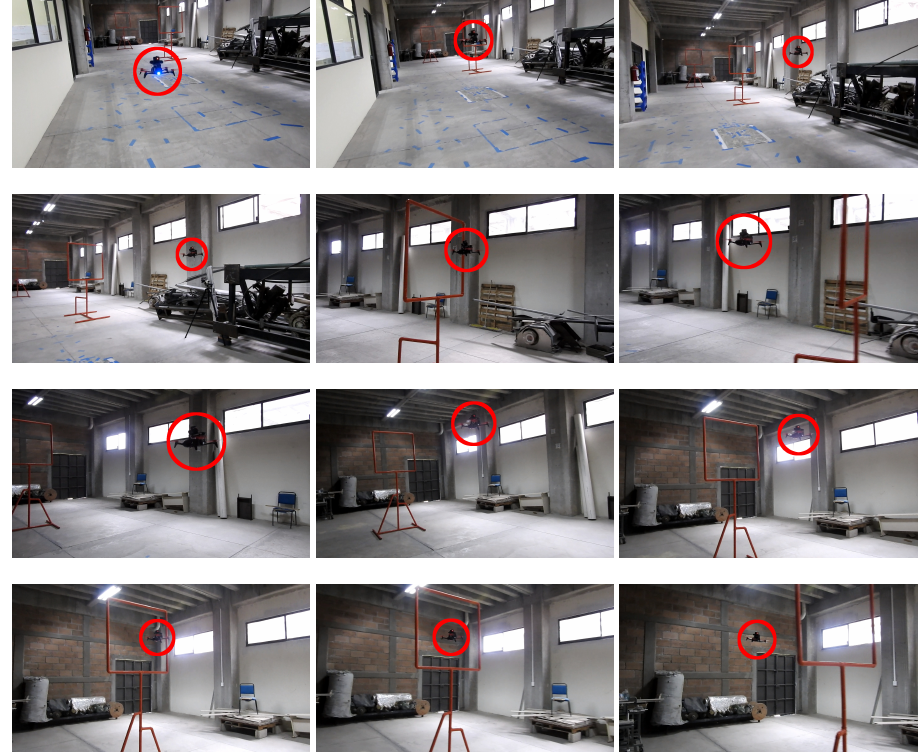
Figure 14. Exterior views of the drone’s performance while the drone flies autonomously in an indoor environment. A video illustrating these experiments is found at https://youtu.be/P1187astpe0 (accessed on 1 November 2021).